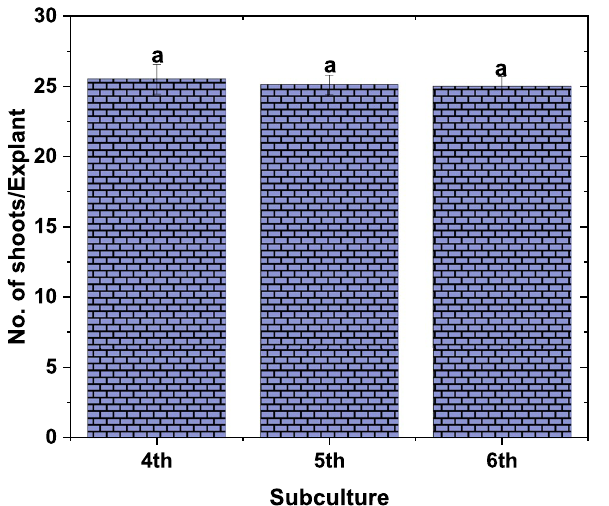
Figure 1. Effect of subcultures on production of multiple shoots in TIB. Experiment carried out with 250 ml of culture medium and 6 numbers of inoculum used and 2-min immersion for every 6 h. results were recorded after 21 days of culture period. (Graph was generated using OriginLab Professional Version 2021b software; URL link: www. Origi nLab. com/ 2021b).